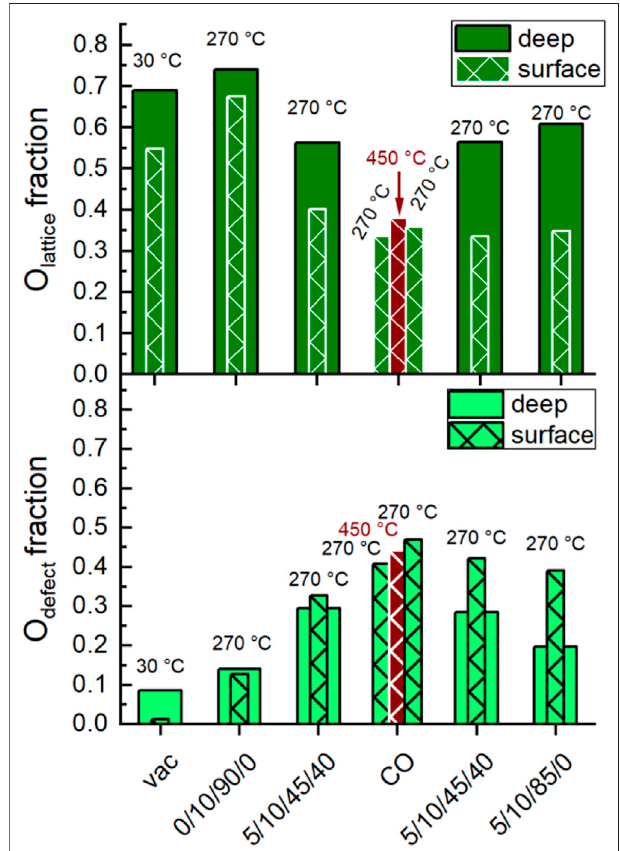
FIGURE8| EvolutionofthefractionofO lattice (top)andO defect (bottom)at different temperatures and feeds (C 3 H 8 /O 2 /He/H 2 O) given below. Deep, fi lled columns: Extracted from O 1s peak fi tting of spectra conducted using 1,300 eV excitation energy. Surface, hatched columns: Extracted from O 1s peak fi tting of spectra conducted using 700 eV excitation energy. Dark red, surface, hatched columns: Extracted from O 1s peak fi tting of spectra conducted at 450 ° C using 700 eV excitation